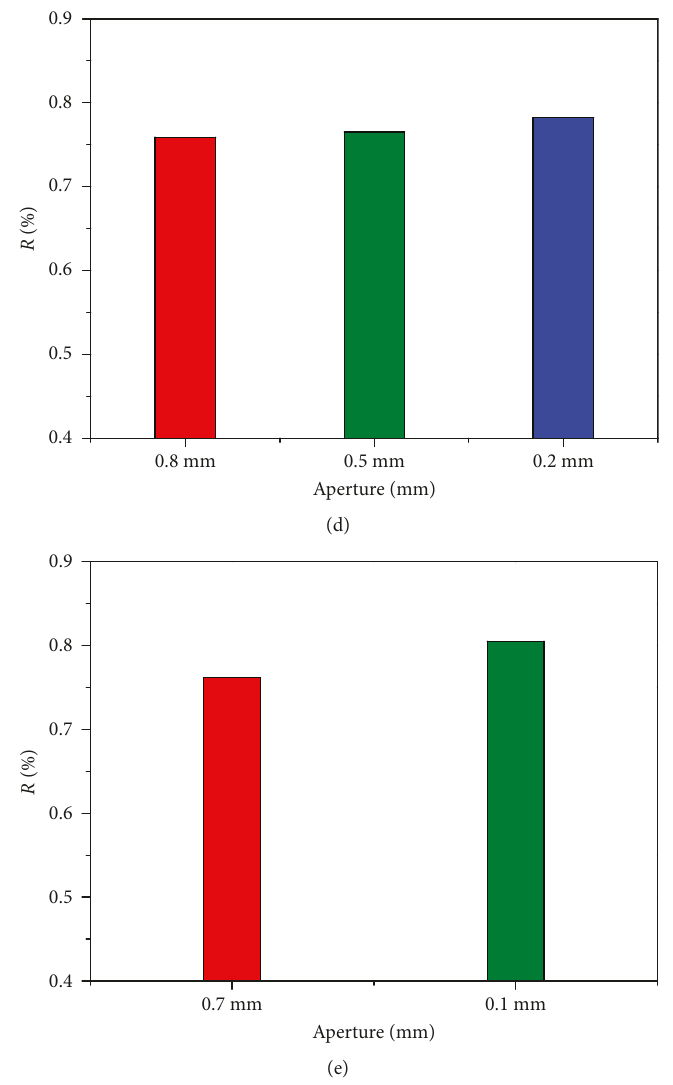
Figure 15: Retention rate at di ff erent apertures: (a) CI, (b) CII, (c) CIII, (d) GHI, and (e)